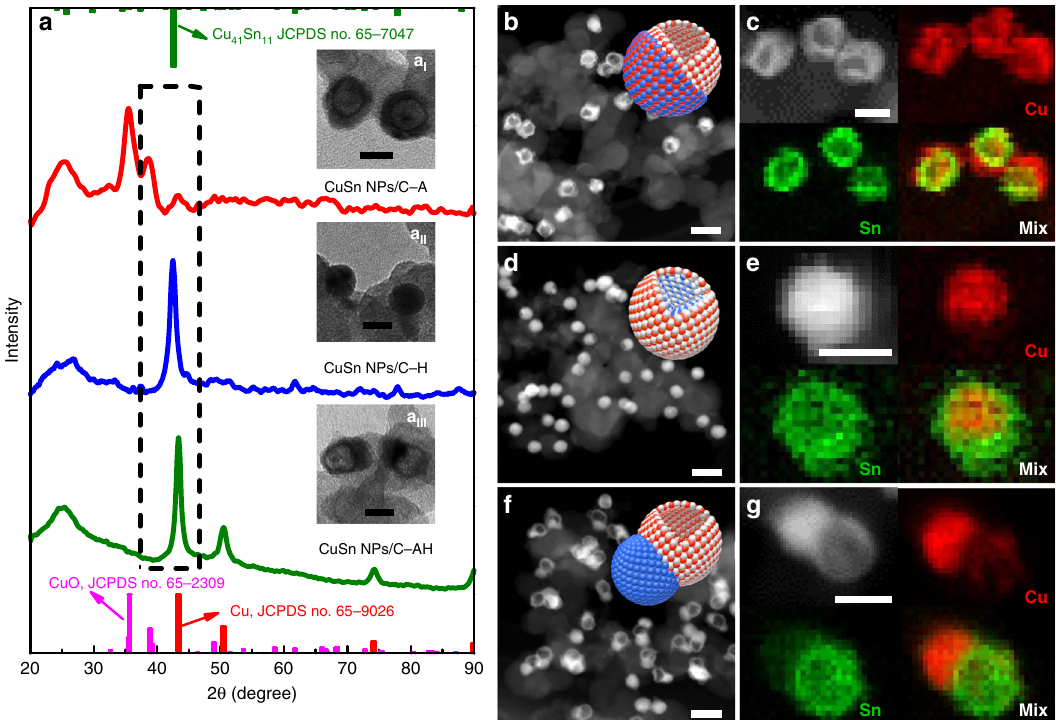
Fig. 2 Structure and phase characterizations of CuSn NPs/C with controlled annealing treatment. a X-ray diffraction (XRD) patterns and inset transmission electron microscopic (TEM) images of a I CuSn NPs/C-A, a II CuSn NPs/C-H, and a III CuSn NPs/C-AH. b , d , f High-angle annular dark- fi eld scanning TEM (HAADF-STEM) images and atom models and c , e , g HAADF-STEM images and energy-dispersive X-ray spectroscopy (EDS) elemental mappings of b , c CuSn NPs/C-A, d , e CuSn NPs/C-H, and f , g CuSn NPs/C-AH. Scale bars, 50 nm in b , d , f , 20 nm in a I – a III , c , e , g . Red, blue, and white spheres in the models represent O, Cu, and Sn atoms,